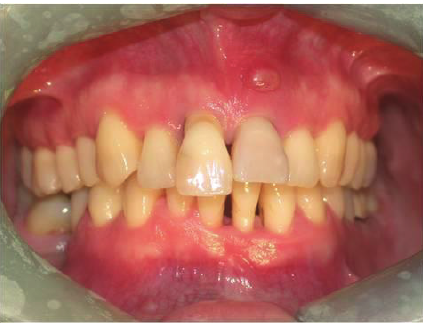
Figure 1: Extent of the patient’s periodontitis upon presentation.